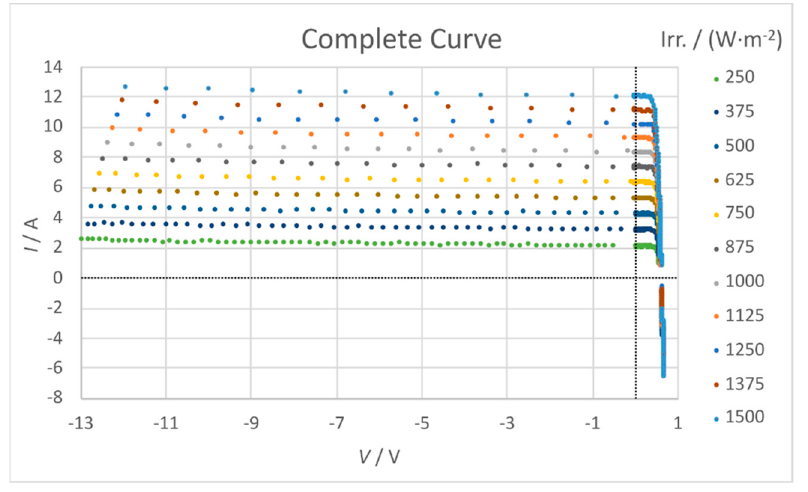
Figure 20. Three-quadrant I-V curves measured with the prototypes at different irradiances from 250 to 1500 W/m 2 .